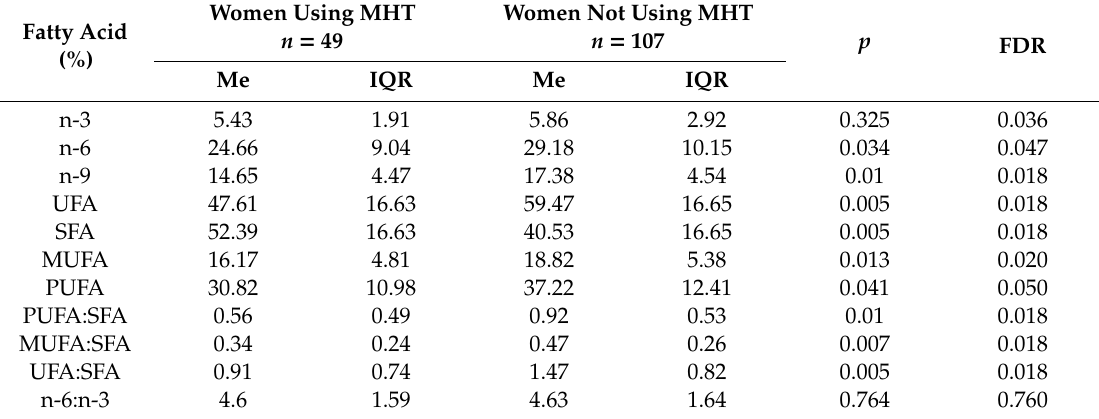
Fatty acid profiles of postmenopausal women in terms of MHT usage using the Mann–Whitney